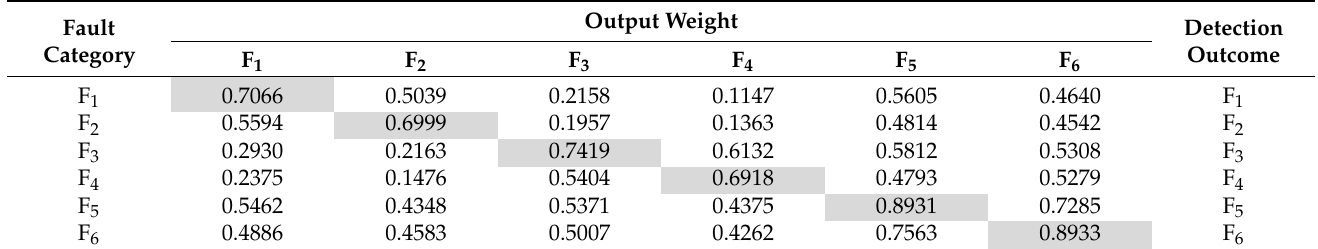
Table 5. Detection outcomes of the inverter at 52 Hz with different fault categories.